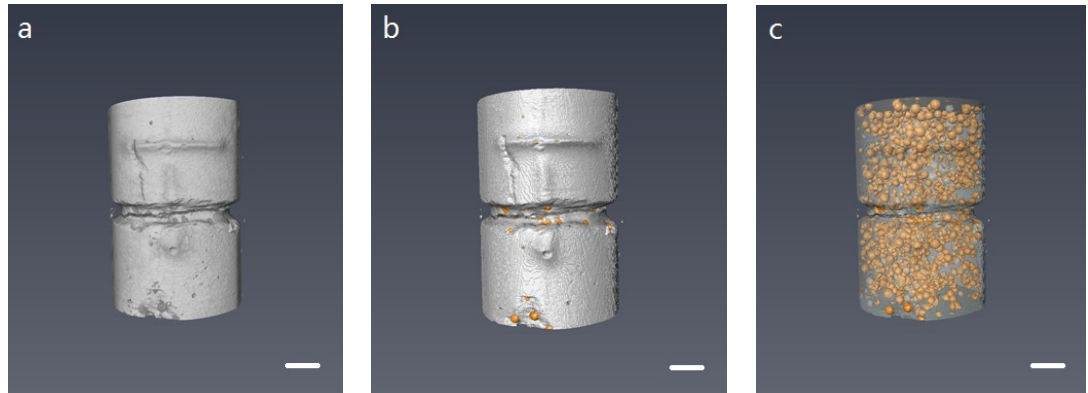
Figure 3. XCT visualization process of microcapsules’ embedded cement paste cylinder including ( a ) volume construction; ( b ) surface generation; and ( c ) transparent adjusting. The scale bar is 2 mm for all three